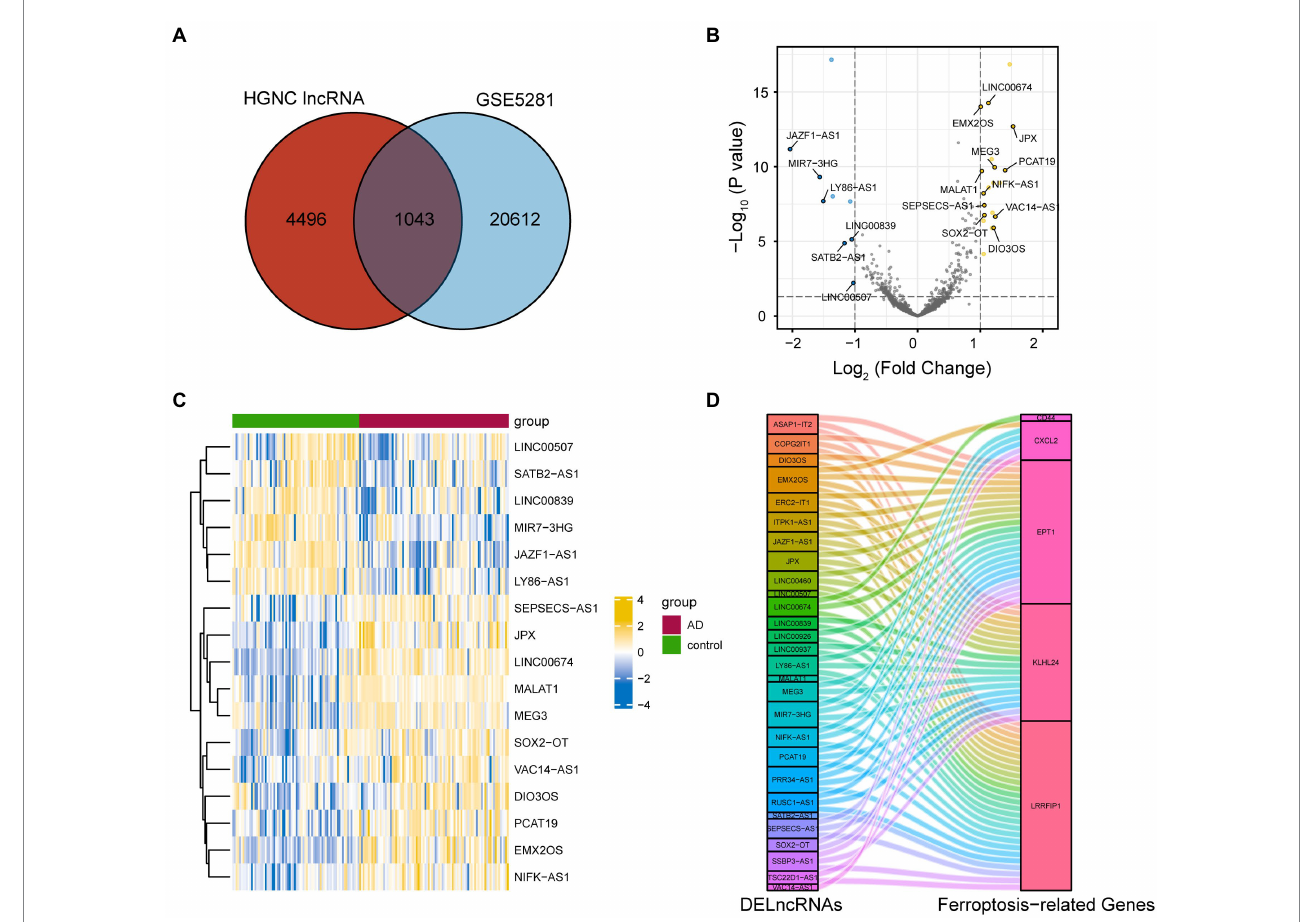
FIGURE 5 Identification of FRGs associated with differentially expressed lncRNAs. (A) A total of 1,043 lncRNA probes in GSE5281. (B) Differentially expressed lncRNAs in GSE5281. (C) The heat map of FRGs associated with differentially expressed lncRNA. (D) Co-expression network of differentially expressed lncRNAs and five FRGs. FRGs, ferroptosis-related genes; lncRNA, long non-coding